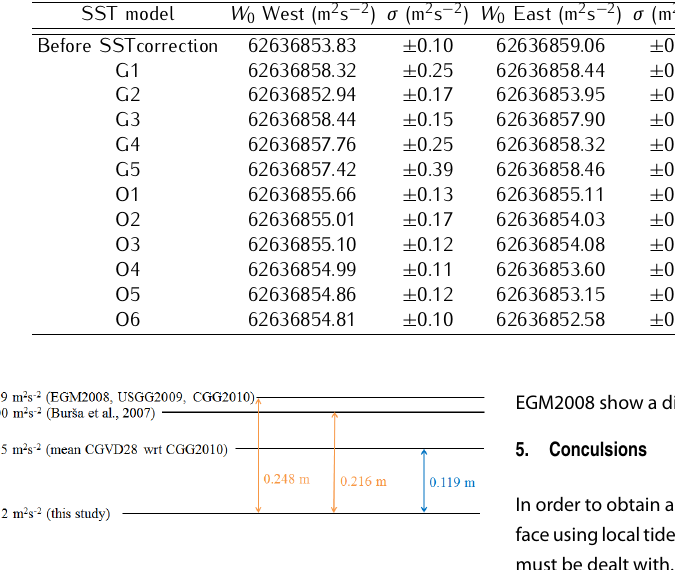
Figure 4. Offsets of the geopotential value 62636858.12 m 2 s − 2 from other known W 0